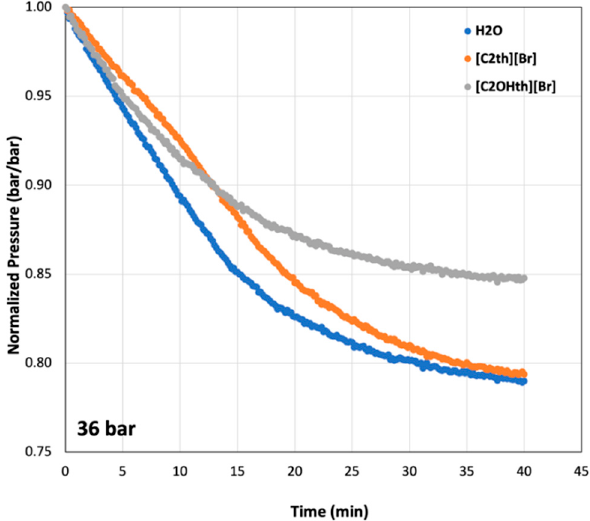
Figure 5. Normalized pressure curves at the initial pressure of 36 bar indicating growth of CO 2 hydrates with time in 1 wt% aqueous solutions of ionic liquids.